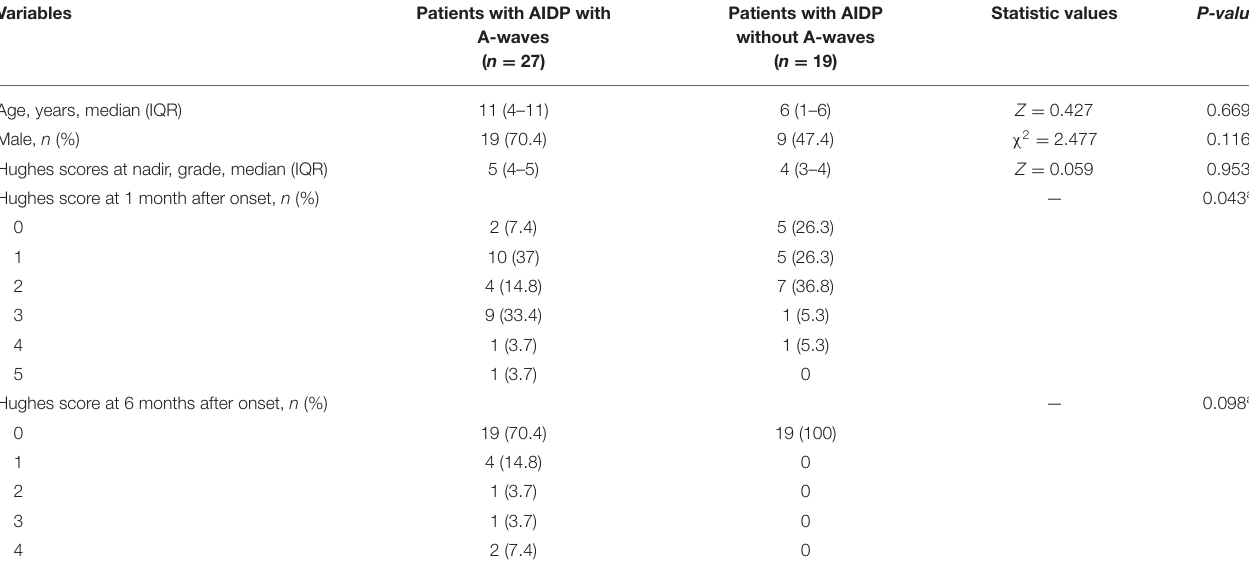
TABLE 3 | Clinical features and Hughes grade between patients with AIDP with A-waves and patients with AIDP without A-waves.